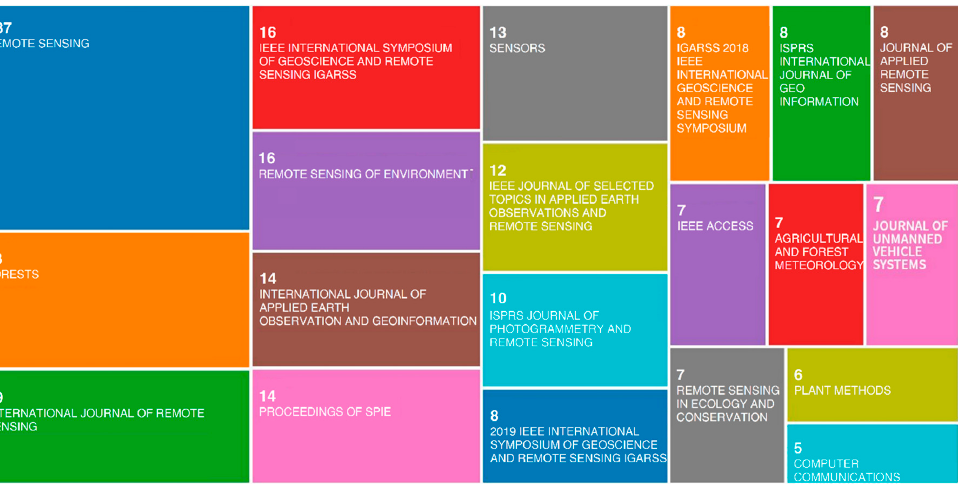
Figure 3. Treemap of the top 20 source titles for the first-step filtering records.